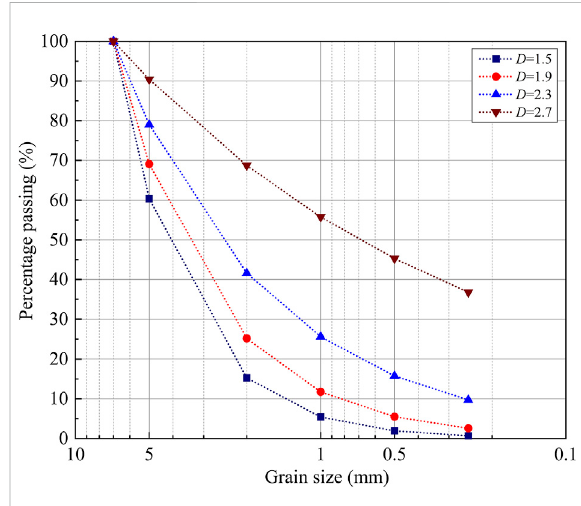
FIGURE 4 Grain size distribution curve of different fractal dimensions.